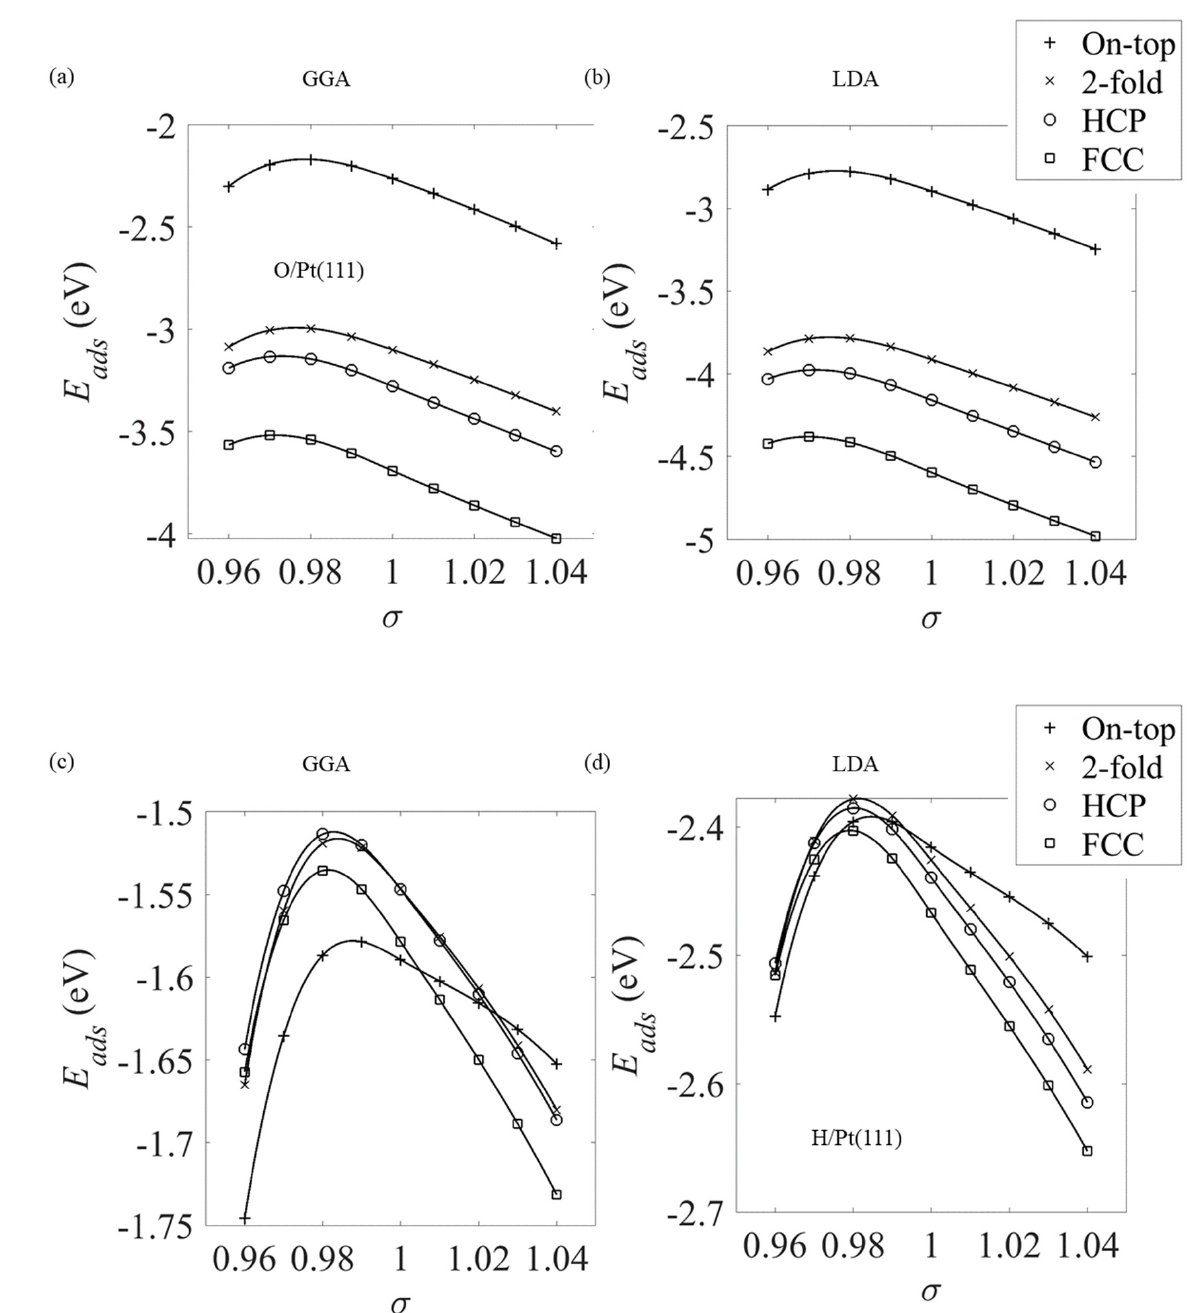
Figure 10. The binding energy of ( a , b ) oxygen and ( c , d ) hydrogen to the on-top, FCC, HCP and two-fold bridge high- symmetry binding positions on the Pt(111) surface as a function of strain σ . The curves were obtained using the ( a , c ) GGA and ( b , d ) LDA estimates of the exchange-correlation.